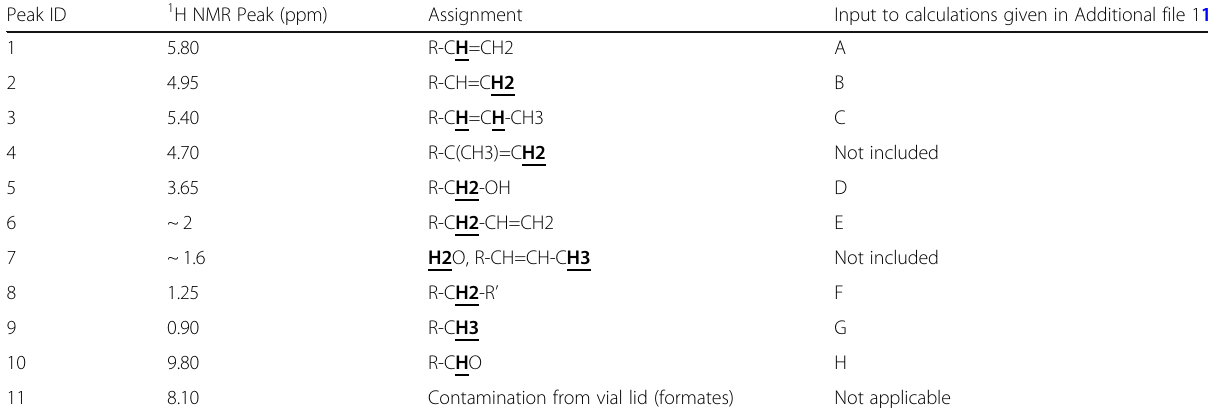
Table 7 1 H NMR Peak assignments in CDCl 3 solvent Peak ID